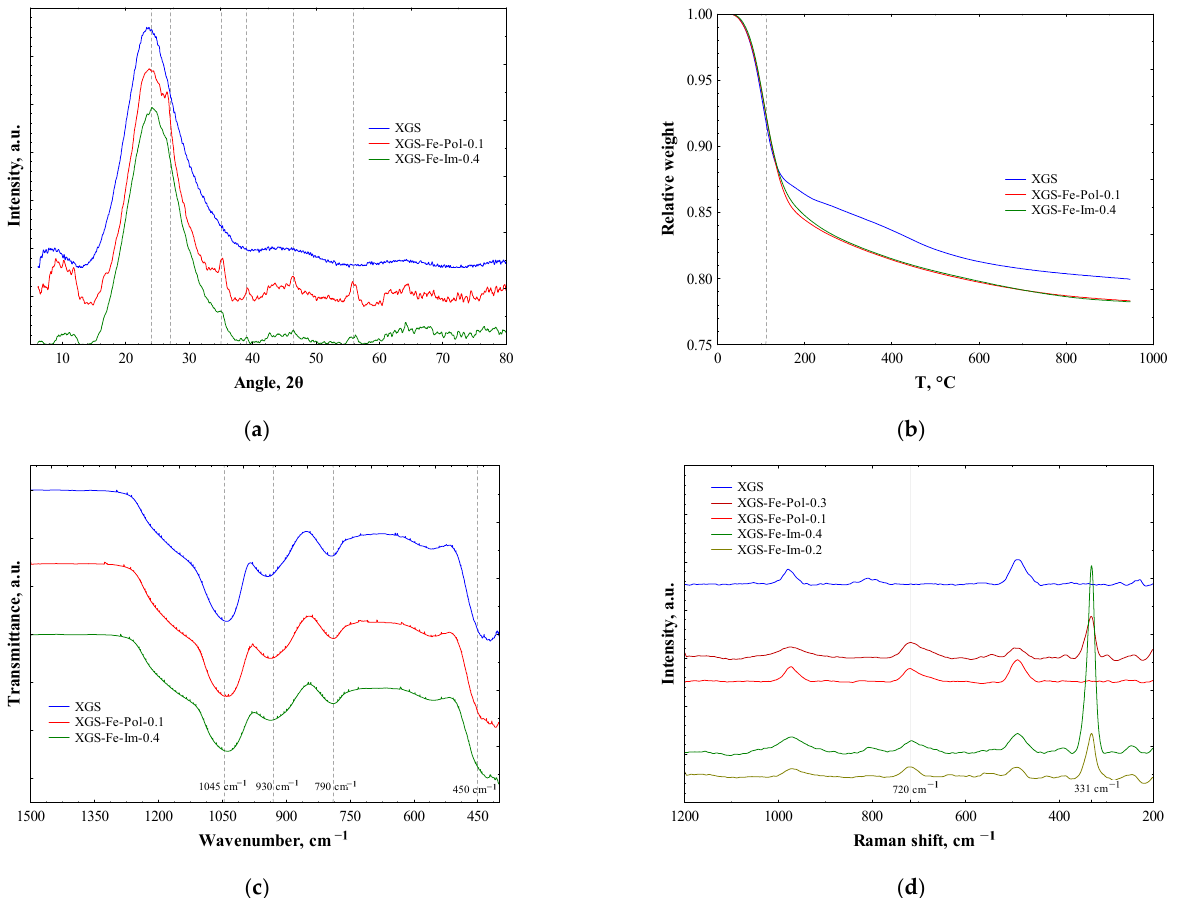
Figure 2. Surface characterization for XGS and the ones doped with iron: XGS-Fe-Im and XGS-Fe-Pol. ( a ) XRD; ( b ) TGA; ( c ) FTIR; and ( d ) Raman spectra.